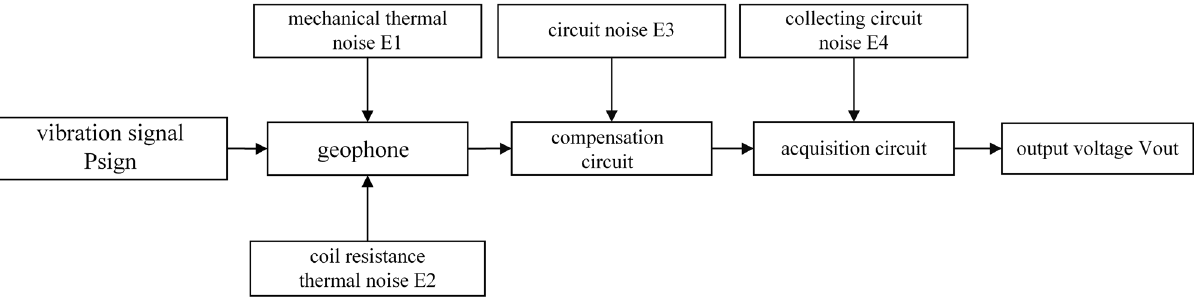
Figure 10. Noise Model.